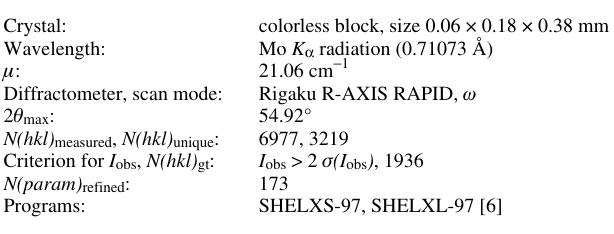
Table 1. Data collection and handling.